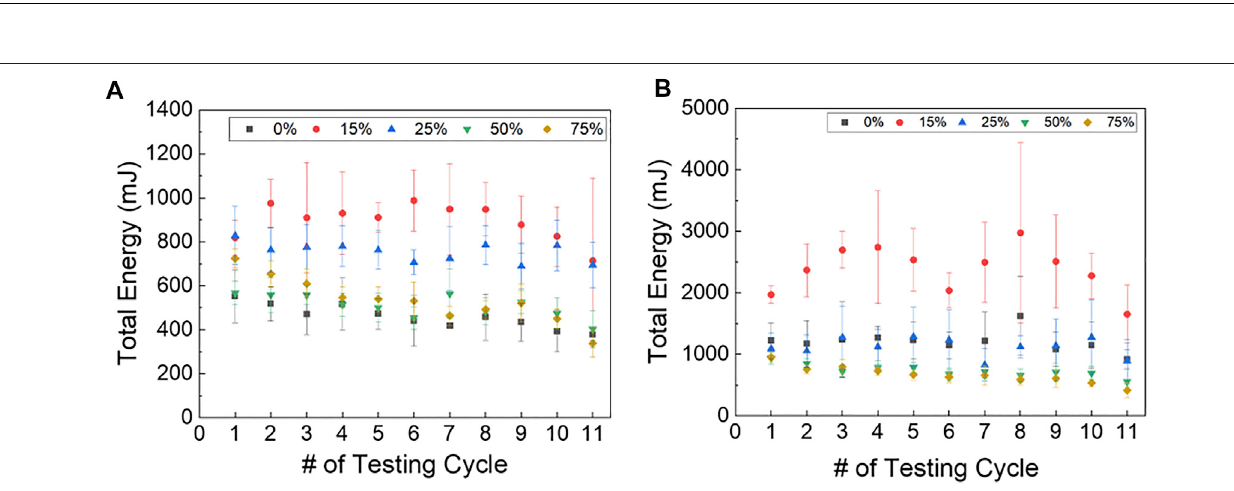
FIGURE 6 | The total energy of the 11 test cycles for (A) A samples and (B) B samples, with 0, 15, 25, 50, and 75% moisture contents. Data points were obtained from steps A 1 0 , A 2 x , B 1 0 , and B 2 x